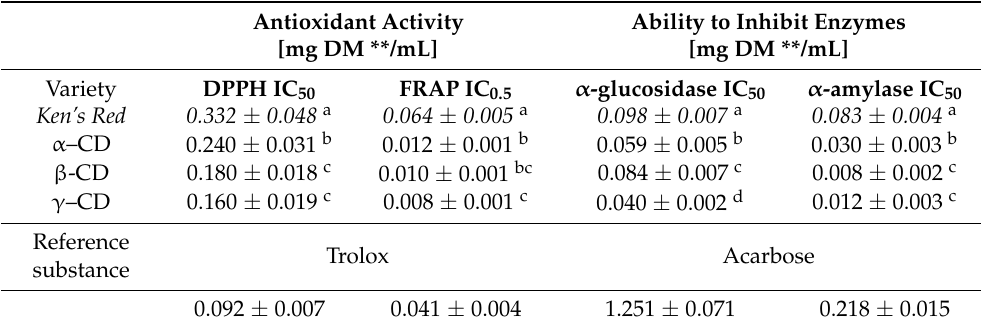
Table 4. IC 50 and IC 0.5 of the antioxidant activity and enzyme inhibition of extracts obtained using selected cyclodextrins. Antioxidant